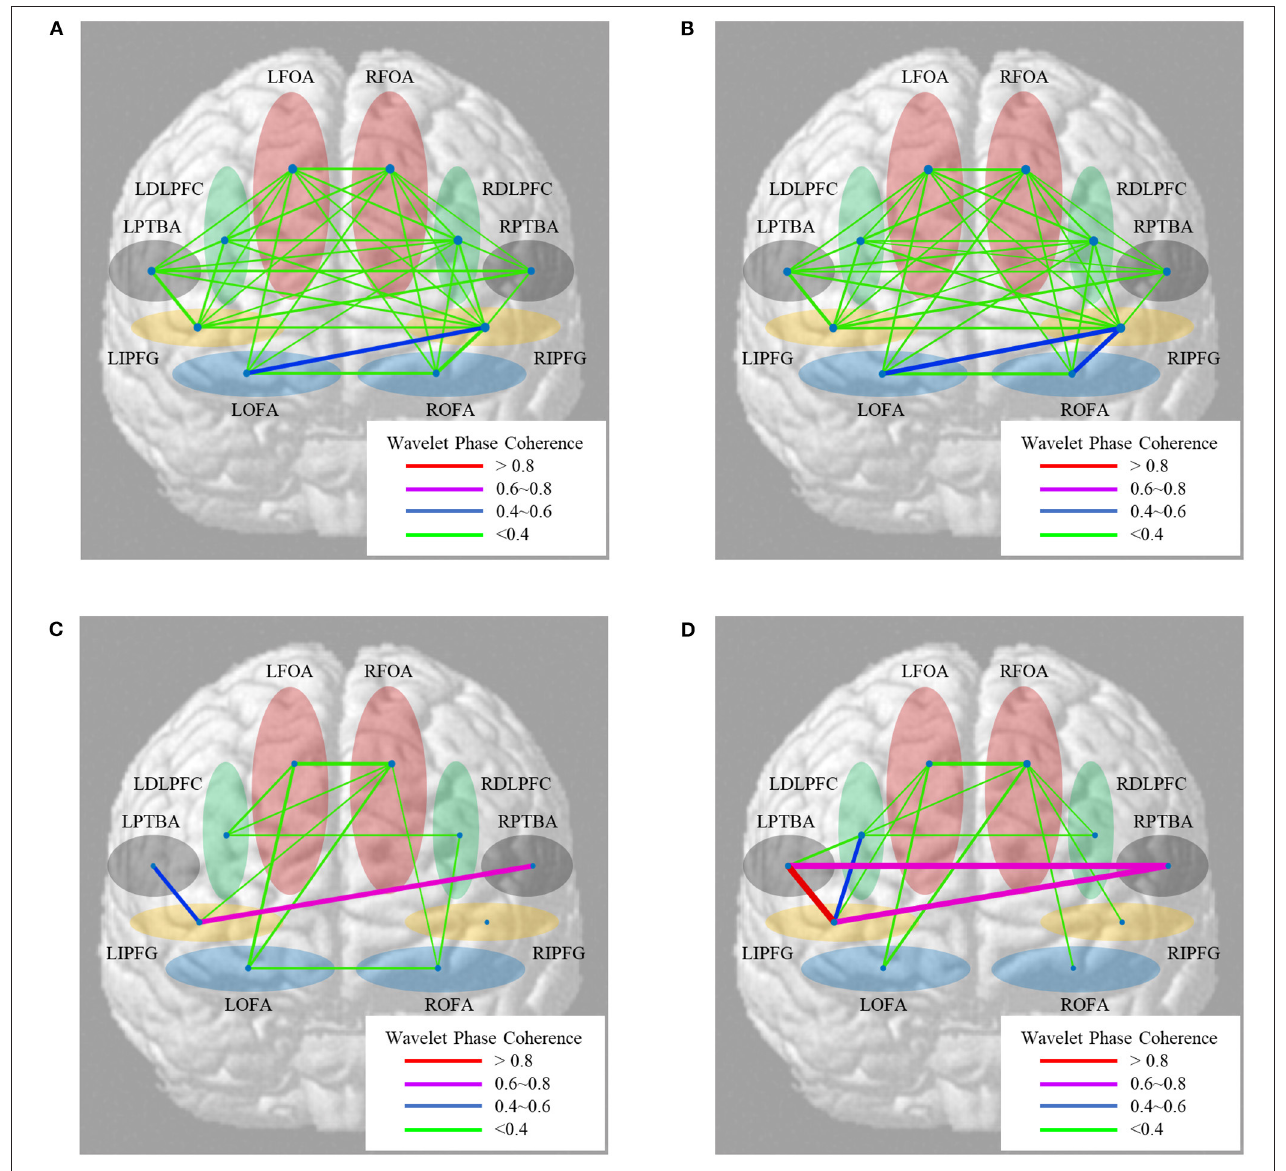
FIGURE 7 | Maps of the functional brain network between brain regions averaging over all subjects. (A) Near-transferred group; (B) far-transferred group; (C) low prior cognitive level group in far transfer; (D) high prior cognitive level group in far